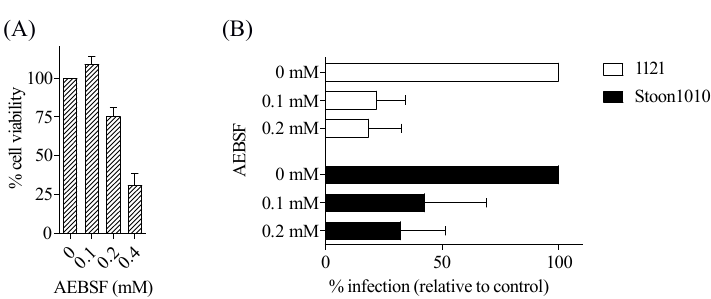
Figure 13. PCV2 disassembly in T-lymphoblasts is mediated by serine proteinases. ( A ) Viability of cells treated with different concentrations of AEBSF, as measured by MTT assay. ( B ) Cells were pre-treated with AEBSF (0, 0.1, 0.2 mM) prior to PCV2 infection. The percentage of PCV2-infected cells was quantified. The infection level in the treated group was expressed as the relative percentage to that of the control group (drug concentration = 0 mM). Data represent means ± SD of triplicate assays.